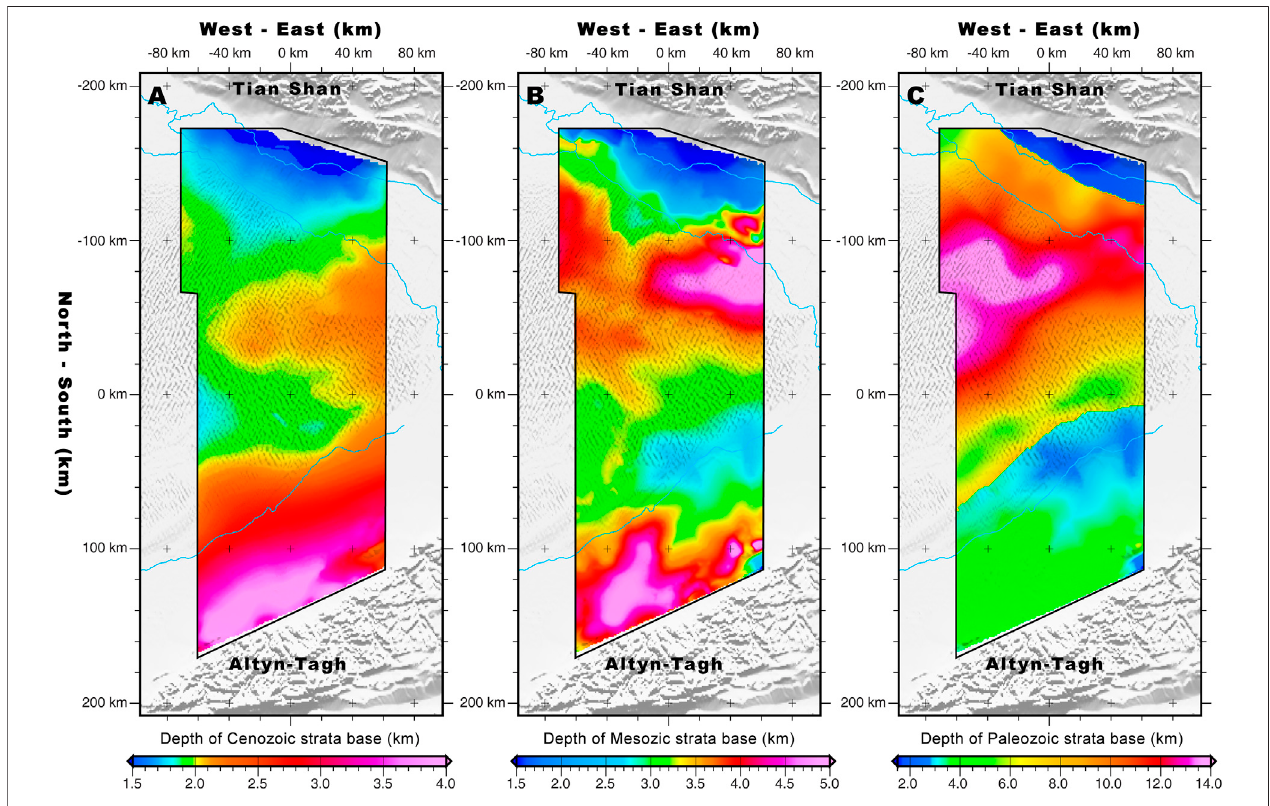
FIGURE 4 | Maps of the strata bottom depth of (A) Cainozoic, (B) Mesozoic, and (C) Paleozoic.